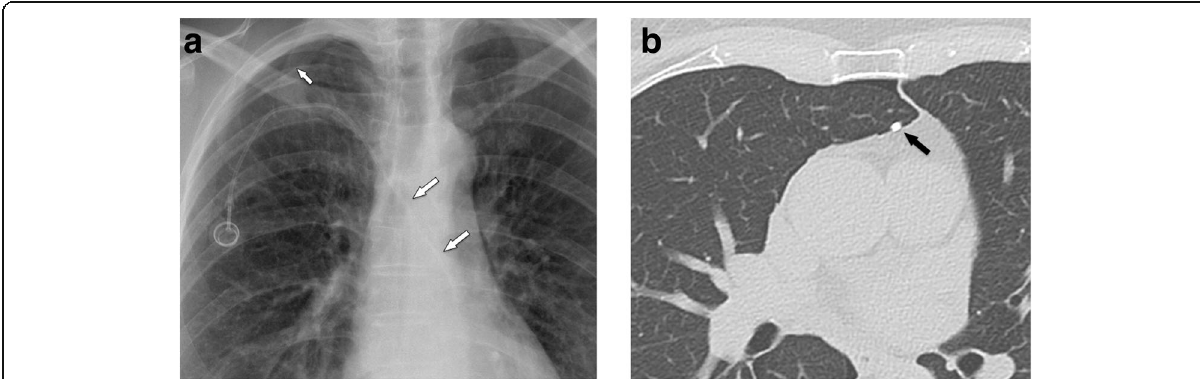
Fig. 8 Malpositioning in the pleural space. a Postoperative chest radiograph shows an abnormal course of the venous catheter, which crosses the midline. A small apical pneumothorax is noted (arrow). b Subsequently, a MDCT was performed, which shows the venous line in the pleural space (arrow) and a pneumothorax